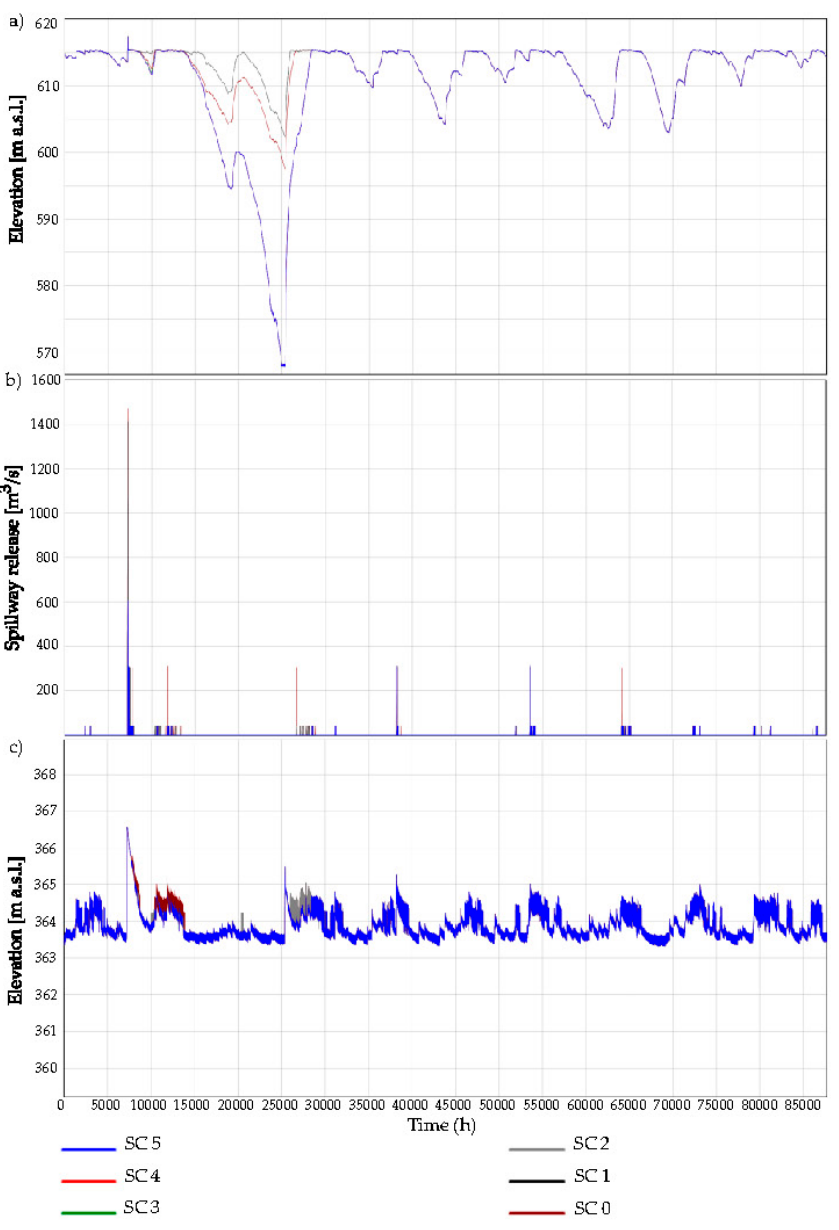
Figure 6. The results of the SDSM: ( a ) Zavoj Reservoir level; ( b ) Spillway release; ( c ) Nišava level at h.s. Pirot.